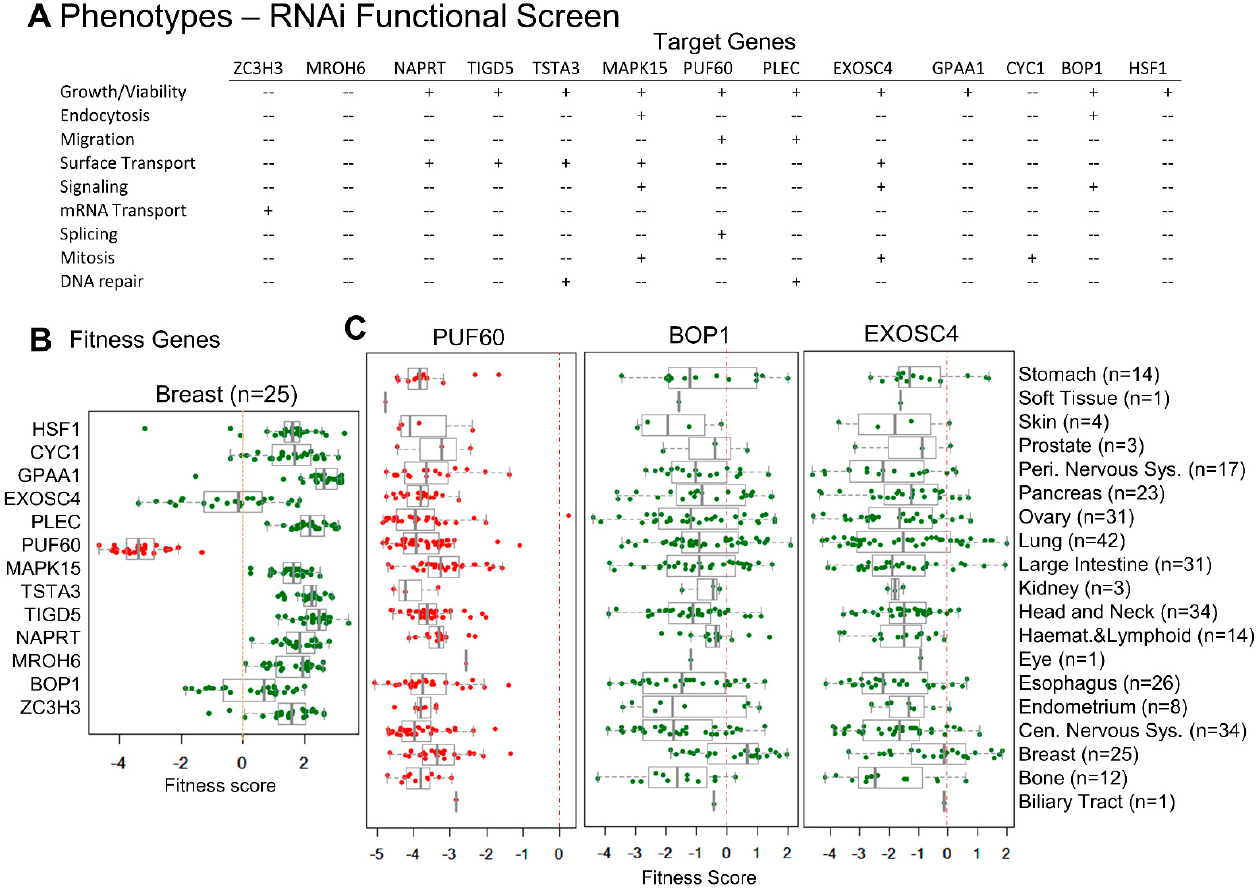
Figure 4. Towards the functions of CanCord34 genes. ( A ) Phenotypic analyses of a subset of CanCord34 genes using the functional RNAi screening database. ( B ) Distribution of a subset of CanCord34 genes as a cellular target with a significant fitness dependency effect upon its knockdown in the test breast cancer cell line. ( C ) Distribution of a subset of CanCord34 genes as a cellular target with a significant fitness dependency effect upon its knockdown in different cancer cell lines.